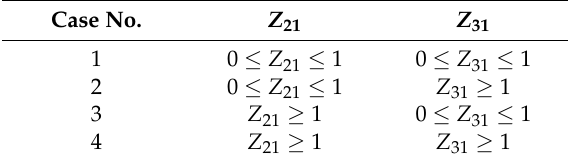
Table 2. Impedance variation parameters for the case study.